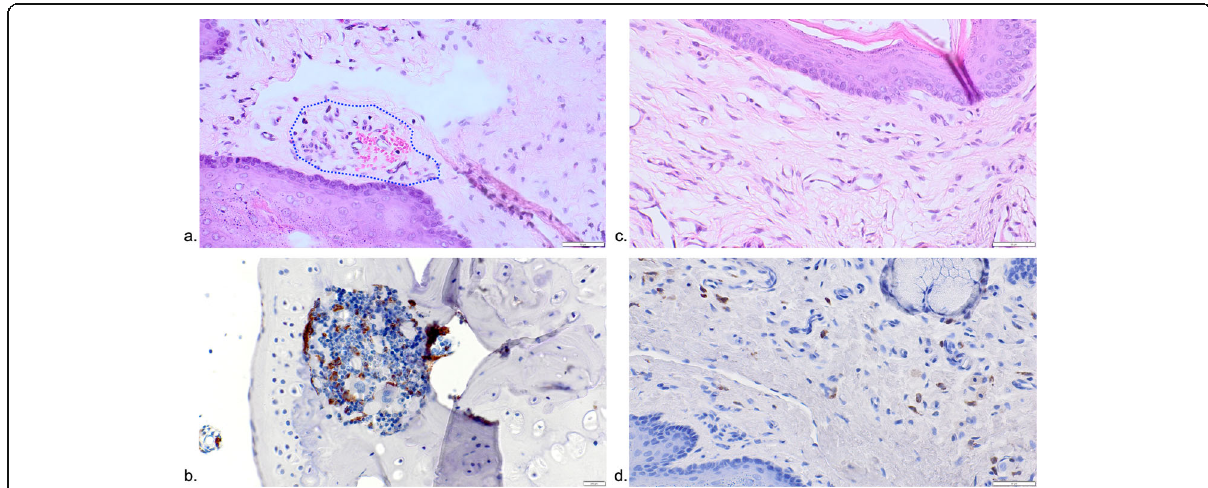
Fig. 2 Representative histological and immunohistochemical views of tissue reactions in the Zo and Zo+Be groups. a Dotted area depicting the only specimen of the Zo group showing a mixed chronic inflammatory cell infiltrate in the subepithelial connective tissue compartment (Zo group, HE stain). b The ICT was commonly composed of CD68-positive cells, lymphocytes, polymorphonuclear leukocytes, and plasma cells (Zo group). c None of the biopsies from the Zo+Be group revealed any detectable ICT areas (HE stain). d Non-infiltrated connective tissue zone with single CD68 counts (Zo+Be group)